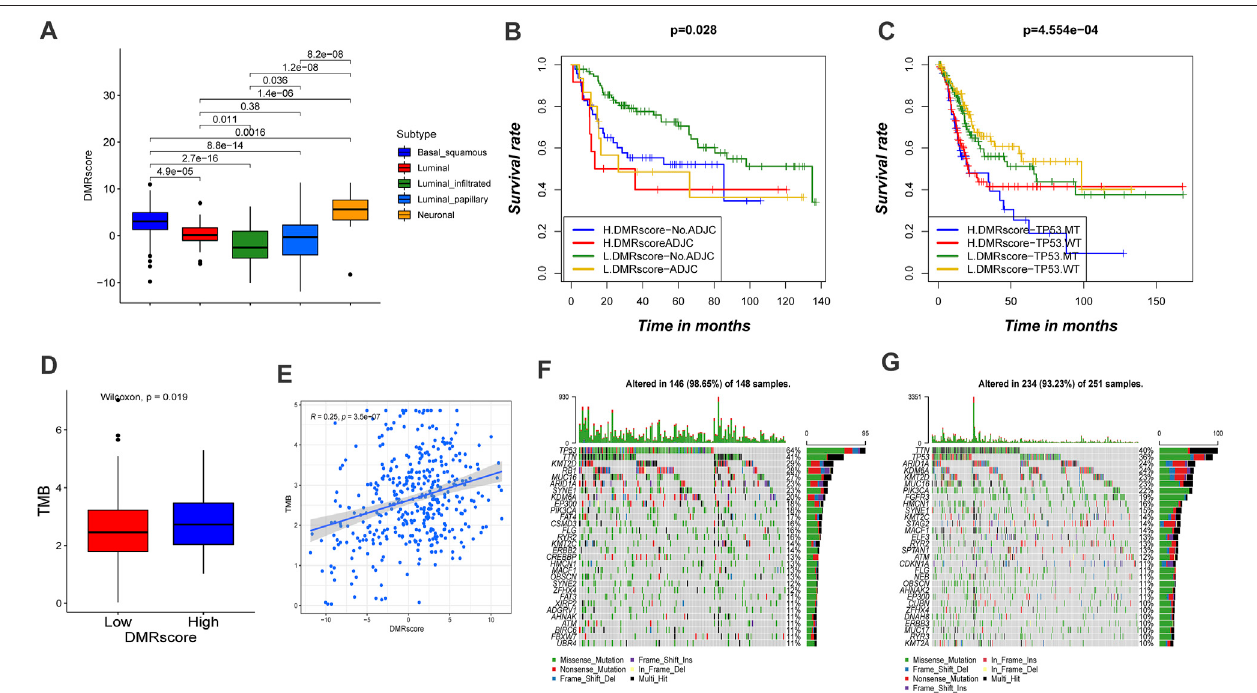
FIGURE5 | Characteristics of DMRscore in TCGA molecular subtypes and tumor mutation burden. (A) Differences in DMRscore among diverse bladder cancer molecularsubtypes.Basal squamoussubtype, blue;Luminalsubtype, red;luminalin fi ltratedsubtype, green; luminalpapillary subtype,sapphire;andNeuronalsubtype, yellow. (B) Kaplan-MeiercurveshowedtheclinicalprognosisofpatientswithcombinationofDMRscoreandadjuvantchemotherapystrati fi cation.H,high.L,low.ADJC, adjuvant chemotherapy ( p (cid:1) 0.028). (C) Kaplan-Meier curve showed the clinical prognosis of patients with combination of DMRscore and TP53 strati fi cation. H, high. L, low. MT, mutation type; WT, wild type ( p < 0.001). (D) Difference in tumor mutation burden between high DMRscore and low DMRscore ( p (cid:1) 0.019). (E) CorrelationbetweenDMRscoreandtumormutationburden.(R (cid:1) 0.25, p < 0.001) (F,G) ThelandscapeoftumorsomaticmutationinTCGA-BLCAestablishedbyhigh (F) and low DMRscore (G) . Each column represented individual patients. The upper barplot displayed tumor mutation burden.